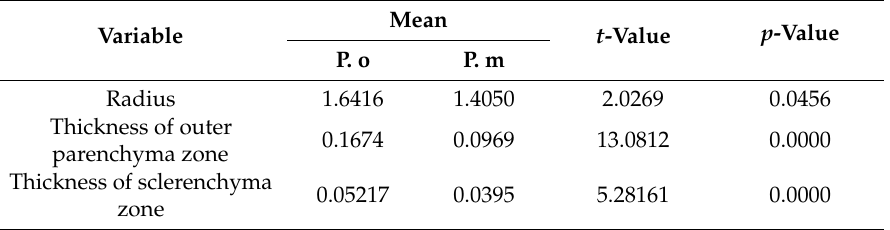
Table 2. Values of Student’s t -test for the mean radius and thickness of the outer parenchyma zone and sclerenchyma zone for the entire length of the shoot of tested plants.